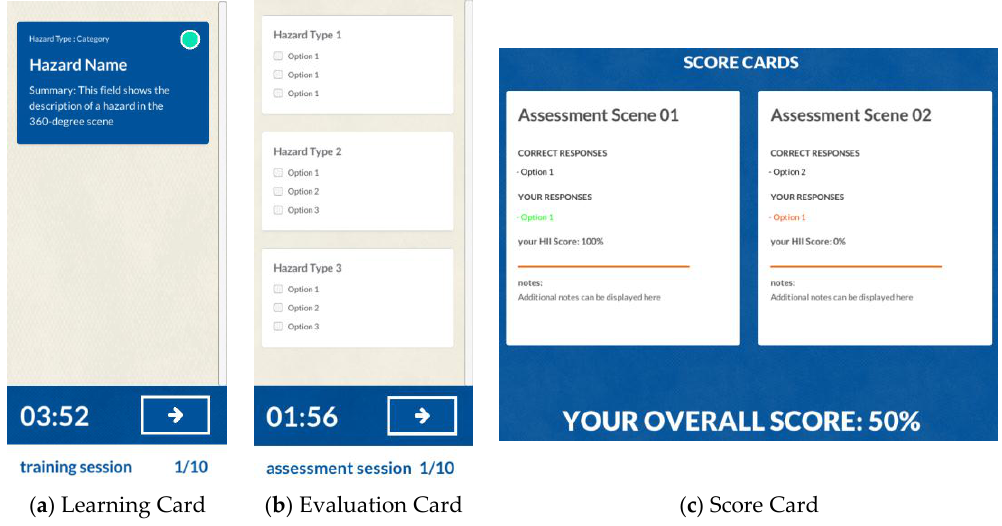
Figure 6. Hazard Identification Panel: ( a ) Learning, ( b ) Evaluation and ( c ) Score Cards